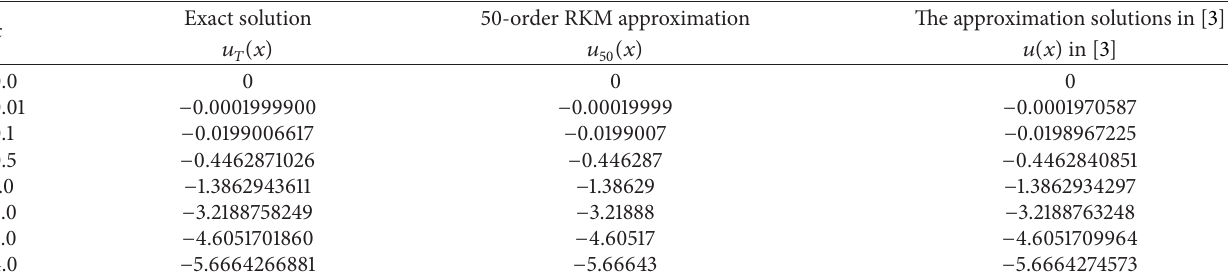
Table 5: Numerical solutions for Example